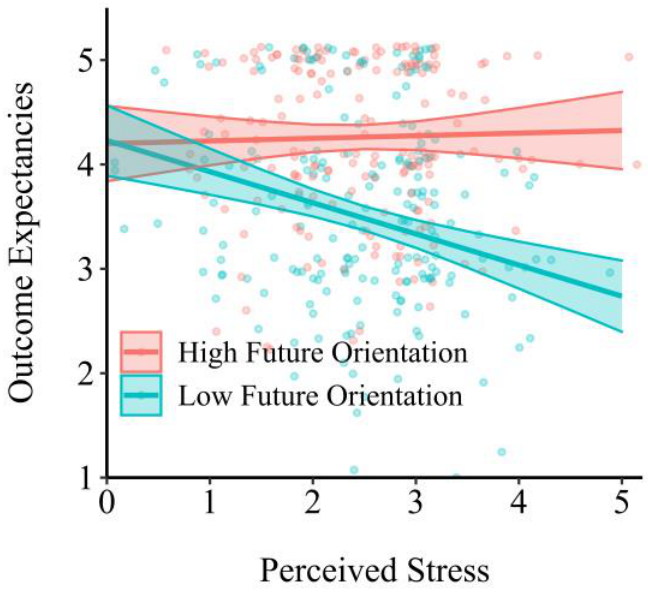
Figure 3. The moderating effect of future orientation.